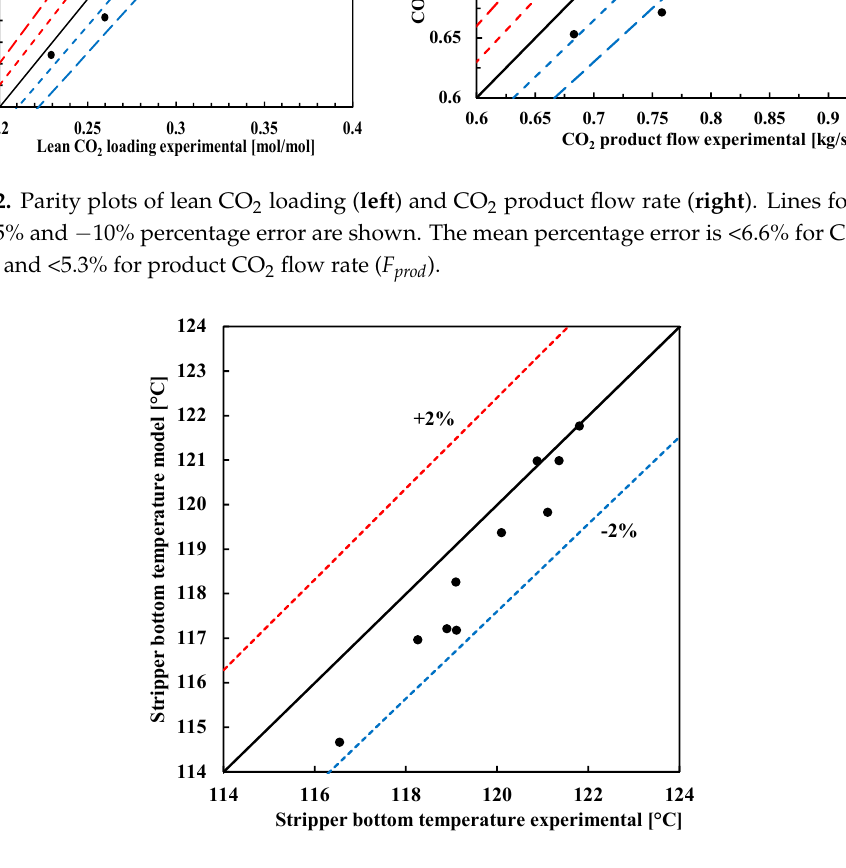
Distance from absorber bottom bed [m] Figure 4. Temperature profiles for absorber column ( left ) and stripper column ( right ) for steady-state cases 1 and 6. In both steady-state operation cases, 24 m of absorber packing were utilized. Validation of absorber and stripper temperature profiles is normally considered a challenging task for several reasons. At TCM DA the temperature profiles are the resulting averaged values of the 4 measurements distributed radially in a given axial position within the column; refer to Section 3. A given pilot plant temperature value presented in Figure 4 is the resulting average over time during one hour of steady-state operating conditions, of the averaged 4 temperature measurements radially distributed within the absorber or stripper column, at the given axial position of the column. The individual temperature measurements are considered reliable and the resulting temperature profiles are reasonable. However, some sensors are located closer to the center of the packing while others closer to the wall. This results in a maximum variation (<6 ° C) which is observed between the measurements in the same radial plane, which depends on operating conditions and is different at different radial planes. Based on the results presented in Figure 4, the dynamic process model can properly predict absorber and stripper column temperature profiles with sufficient accuracy considering the purpose of application. Absorber temperature profiles predicted by the model show a good agreement with the experimental pilot plant data, and the model is capable of properly